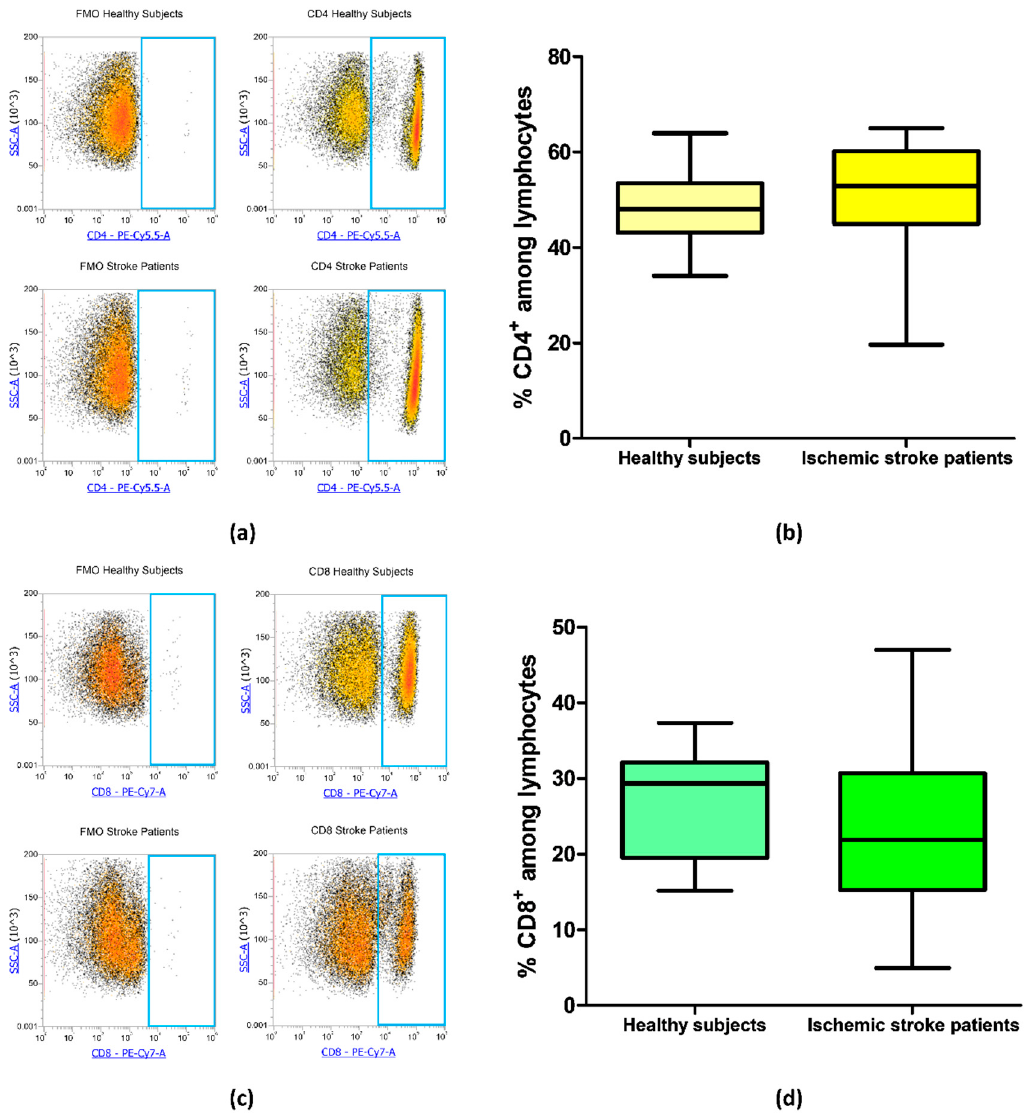
Figure 2. ( a ) Exemplary flow cytometry density plots showing Fluorescence Minus One (FMO) control and CD4 stained cells in lymphocytes from healthy subjects and ischemic stroke patients. ( b ) Box and whiskers plot showing the percentage of CD4 + lymphocytes in healthy subjects (n = 20) and ischemic stroke patients (n = 21) . ( c ) Representative density plots showing FMO control and CD8 stained cells in lymphocytes from healthy subjects and ischemic stroke patients. ( d ) Graphical representation of flow cytometry data showing the percentage of CD8 + lymphocytes in healthy subjects (n = 20) and ischemic stroke patients (n = 21) . Data are shown as the median, interquartile range and the minimum and maximum values.